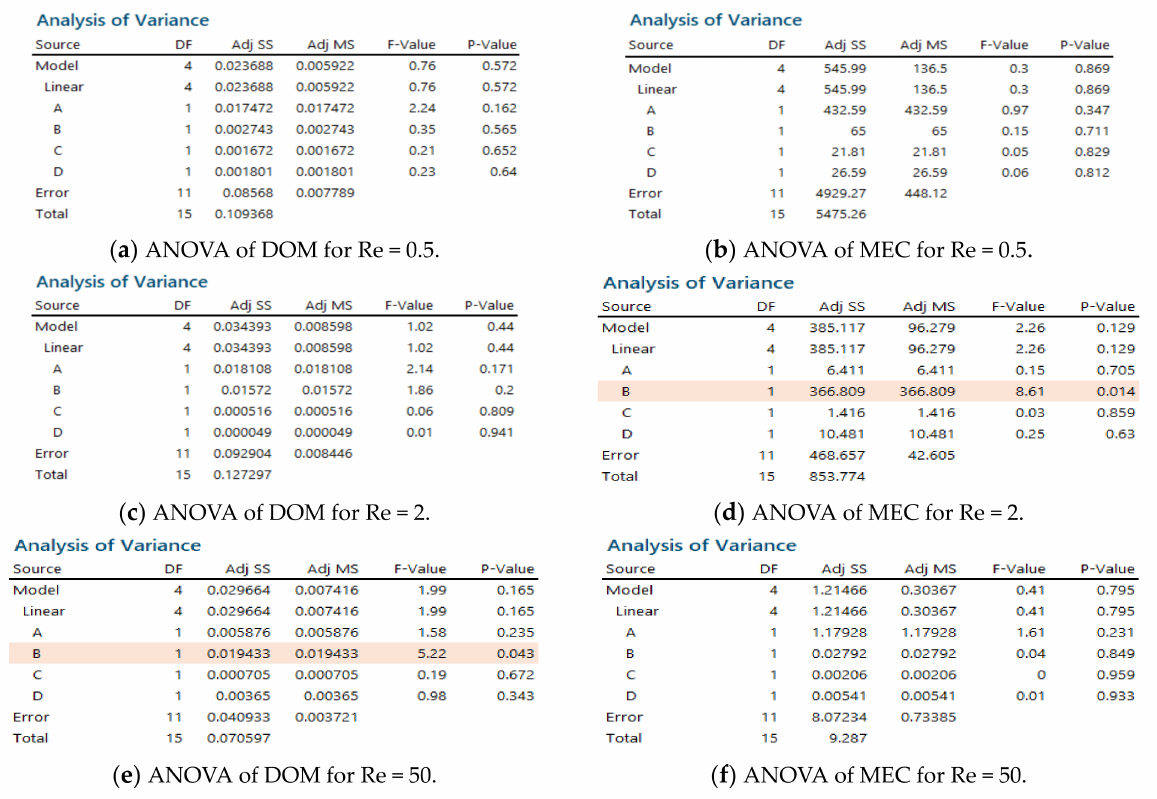
Figure 11. Statistical analysis of the four combination schemes. Combination scheme (B), which had different mixing units in the first combination unit, was statistically significant. It was generalized by applying it to other combination units (2, 3, and 4). For this study, the full factorial method was used to generate all possible designs of the four combination units. For each combination unit, either 1 (same mixing unit: two CC-SAR and two MC-B), or 2 (different mixing units: (CC-SAR and MC-B) and (MC-B and CC-SAR)) were chosen. The 16 micromixer designs listed in Table 4 are the results of the full factorial method. For example, combination #9 resulted when level 2 was chosen for all four combination units. It was obtained by applying the general combination scheme in every two consecutive mixing slots; its mixing performance was expected to be the best among the sixteen combinations. Additional simulations were carried out to evaluate the statistical significance of the general combination scheme of the two mixing units. The simulations were made for Re = 2 and 50; each represented the mixing regime of transition or advection dominance,